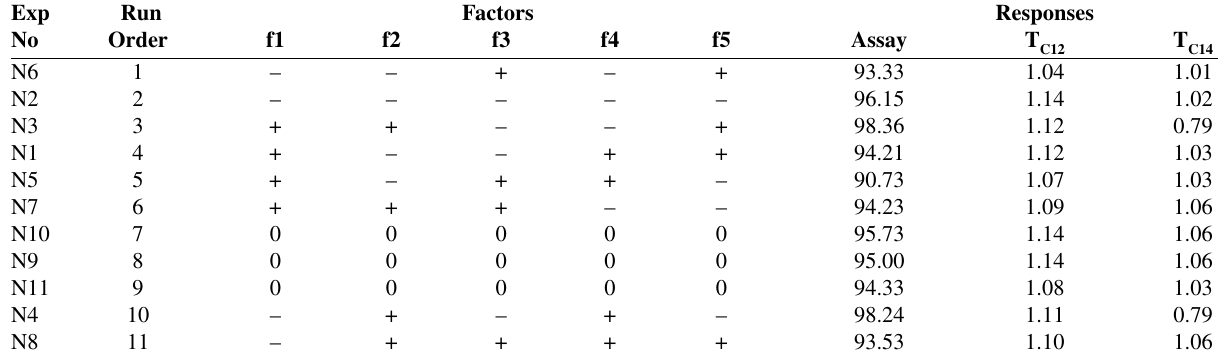
Table 6. Randomized 2 7–3 fractional factorial design used for sample preparation optimization with results for observed responses.